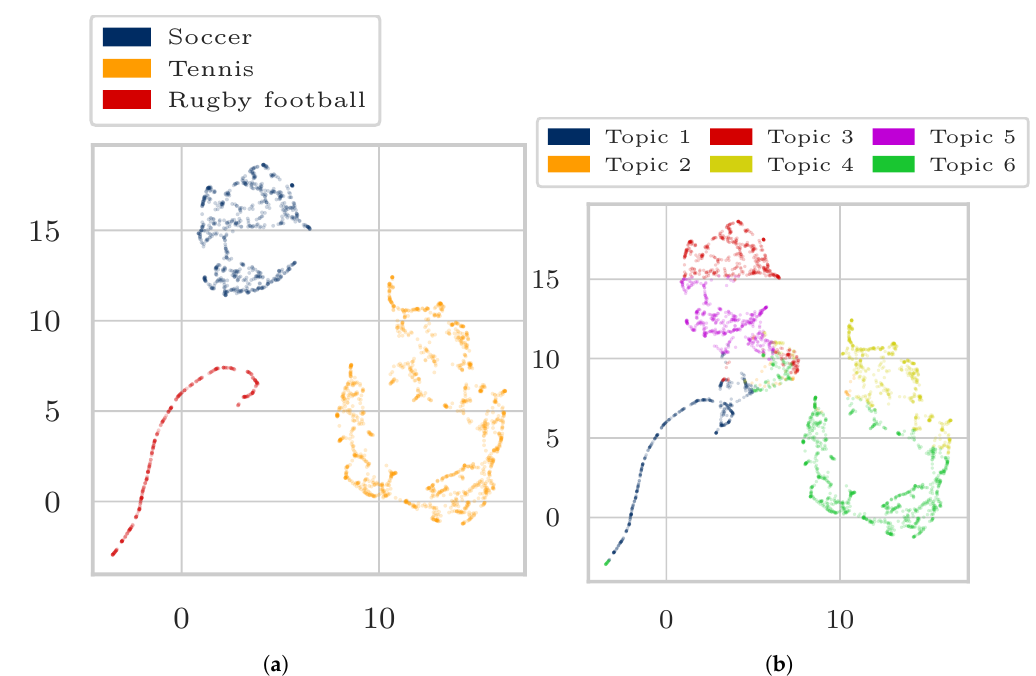
Figure A3. ( a ) 2-dimensional representation of word embeddings A (cid:48) colored by topic assignment. ( b ) 2-dimensional representation of word embeddings A (cid:48) colored by original Wikipedia article assignment (words that occur in more than one article are excluded).